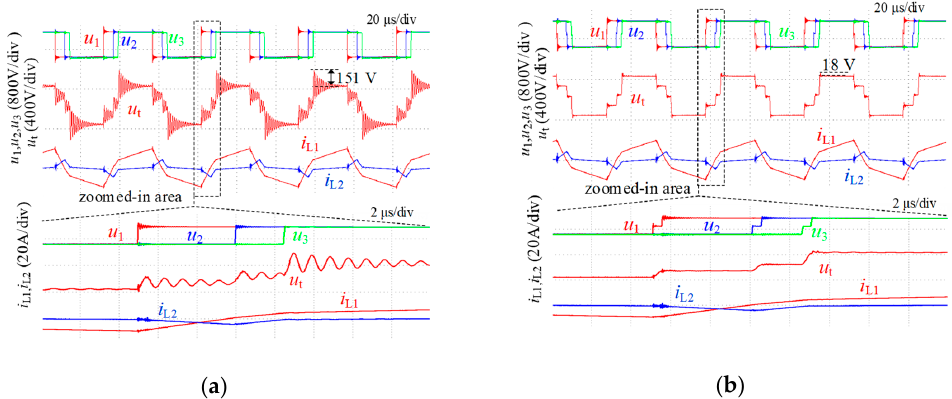
Figure 14. Waveforms of the TAB converter with forward power flow ( D 1 = 0, D 2 = 0.2, D 3 = 0.3): ( a ) no suppression; ( b ) with the SHE PS method.